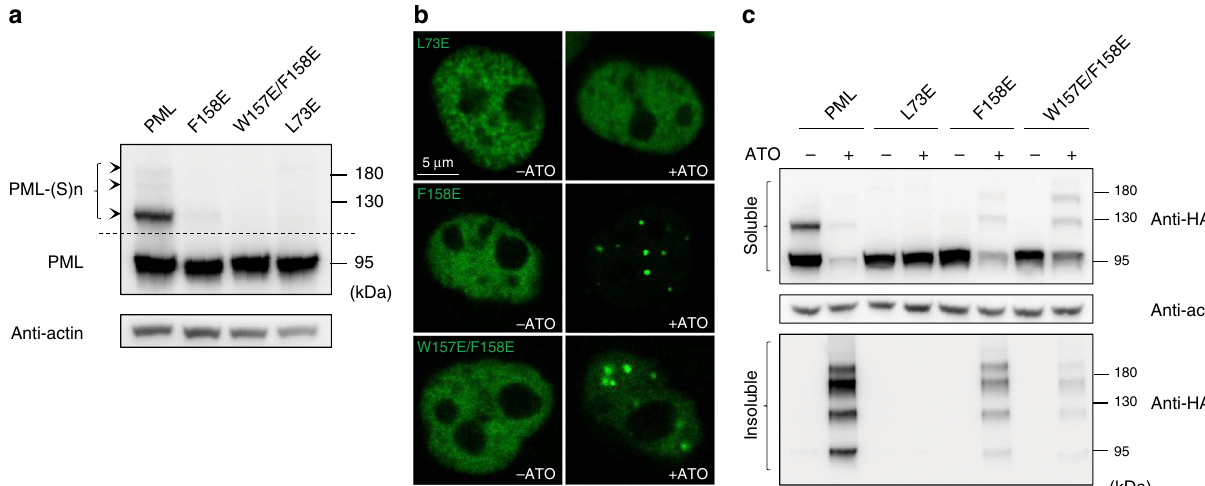
Fig. 7 B1-oligomerization might occur after RING tetramerization. a Auto-sumoylation of PML RING and B1 mutants at basal level. The auto-sumoylation of HeLa Pml − / − expressing B1 and RING mutants was monitored by western blot using antibody against HA tag. Source data are provided as a Source Data fi le. b NB formation rescued by ATO. Left columns: HeLa Pml − / − cells without arsenic treatment. Right columns: One-hour exposure of 2 μ M As 2 O 3 before visualization. c PML sumoylation rescued by ATO. The WT and mutant cells, which had been treated with 2 μ M As 2 O 3 , were disrupted by RIPA buffer. The PML sumoylation that precipitated the soluble PML into insoluble matrix was analyzed by western blot using antibody against HA tag. Source data are provided as a Source Data fi